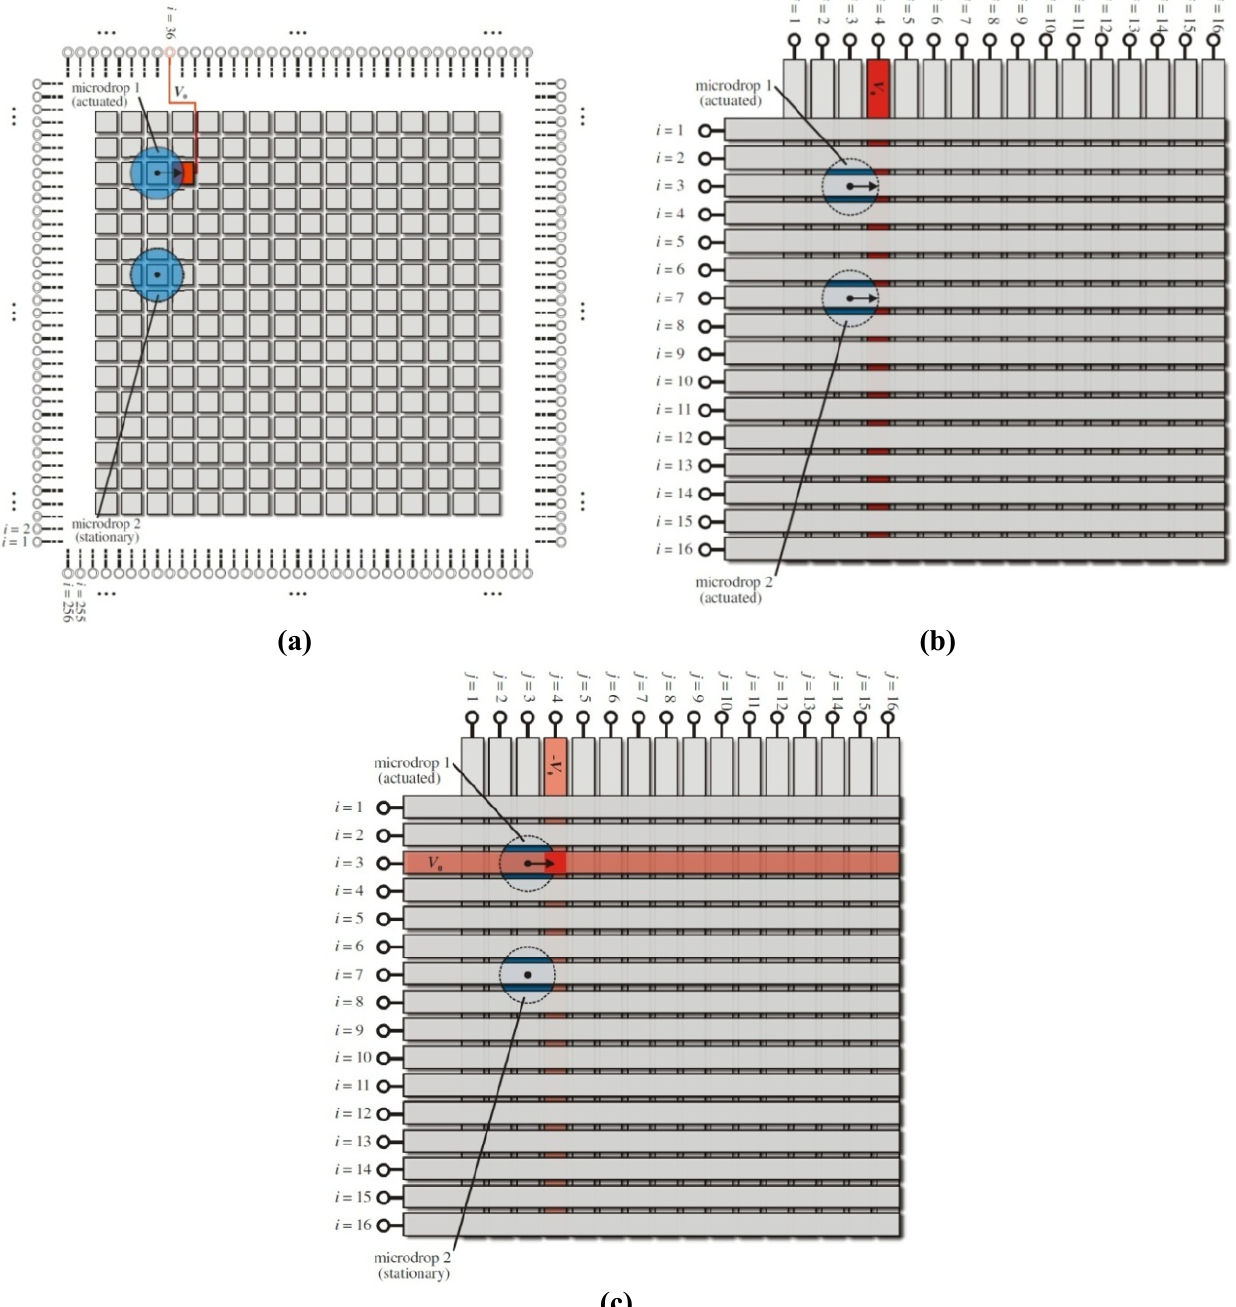
Figure 1. Generalized schematics are shown for (a) a square electrode grid; (b) a linear microdrop addressing/actuation cross-referencing grid; and (c) a nonlinear microdrop addressing/actuation multiplexer grid. In the square electrode grid of (a), a voltage is applied to the right of microdrop 1, on the i = 36 electrode, and this microdrop moves to the right while microdrop 2 remains stationary. Each square electrode is connected to an external terminal (not shown). In the cross-referencing grid of (b), the applied voltage amplitude is much greater than the threshold voltage ( i.e. , V >> V ), resulting in 0 th motion of both microdrops 1 and 2. In the multiplexer grid of (c), the applied voltage magnitude is greater than one-half of the threshold voltage but less than the threshold voltage ( i.e. , V /2 < V < V ), resulting in motion of only microdrop th 0 th